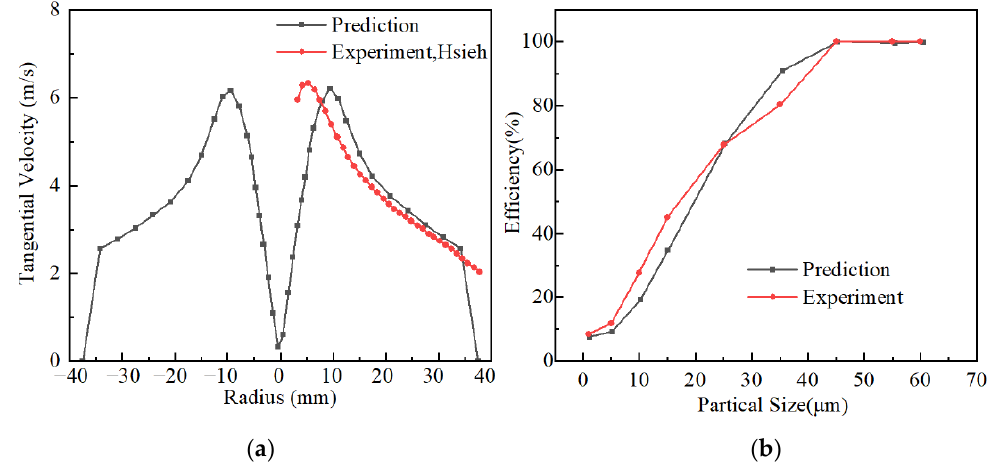
Figure 5. Validation data for the mathematical modeling. ( a ) Validation of VOF ( b ) Validation of